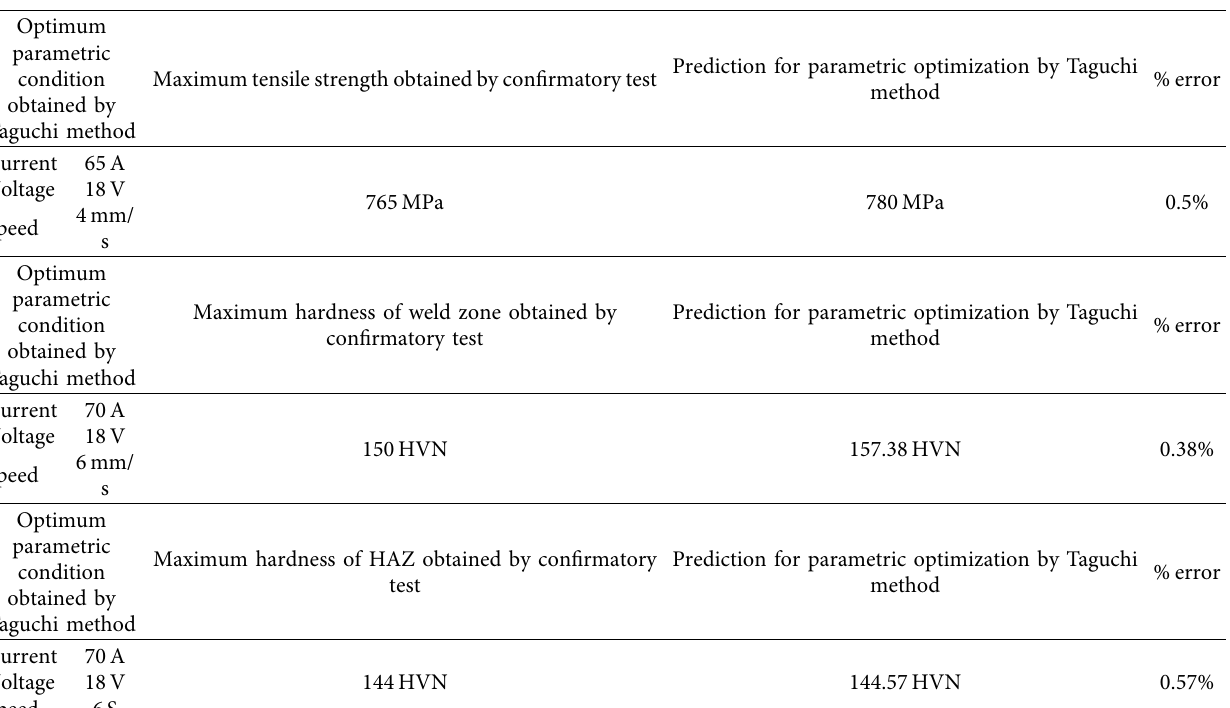
Table 18: Compression between actual (experimental value) and theoretical (expected value) values of tensile strength, hardness of weld zone, and hardness of